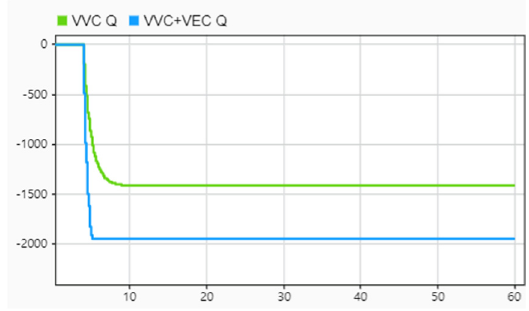
Figure 14. Reactive power output of G1 Inverter.